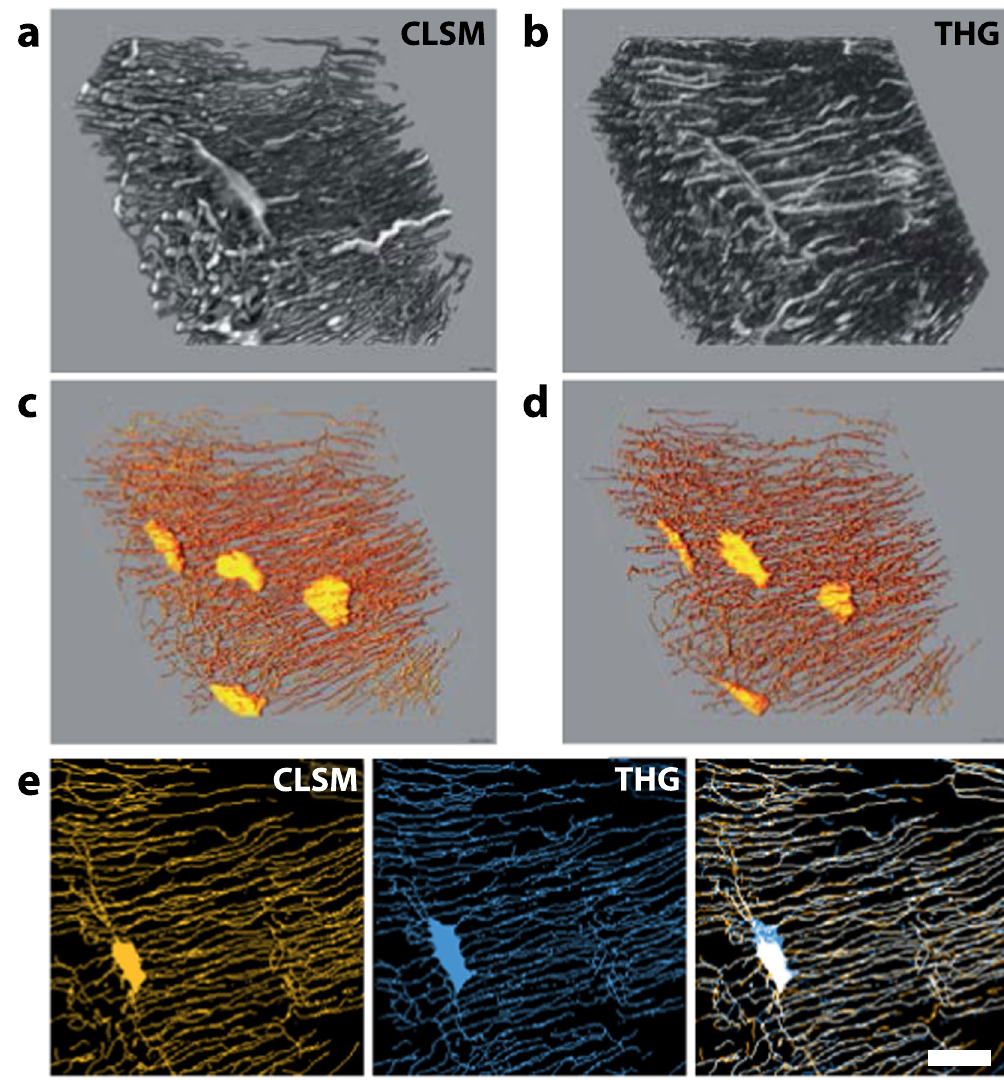
Figure 4. 3D segmentation of the LCN. 3D reconstructions of a 50 × 50 × 20 μ m 3 volume of a bovine femur imaged with THG ( a ) and confocal fluorescence (CLSM, b ). ( c ) (resp. ( d )), skeletonization of the segmented signal shown in ( a ) (resp. ( b )). ( e ) Comparison of the LCN skeleton calculated from fluorescence (CLSM, left) and THG (middle) images. The overlay of the two retrieved skeletons (right) highlights the consistency of the results obtained with the two techniques. Scale bar, 10 µ